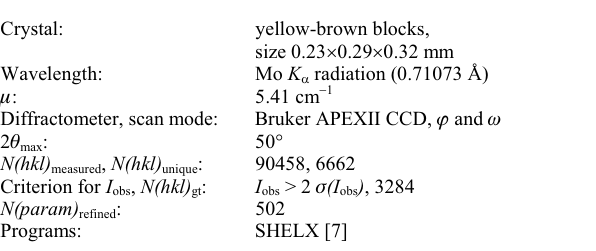
Table 1. Data collection and handling.